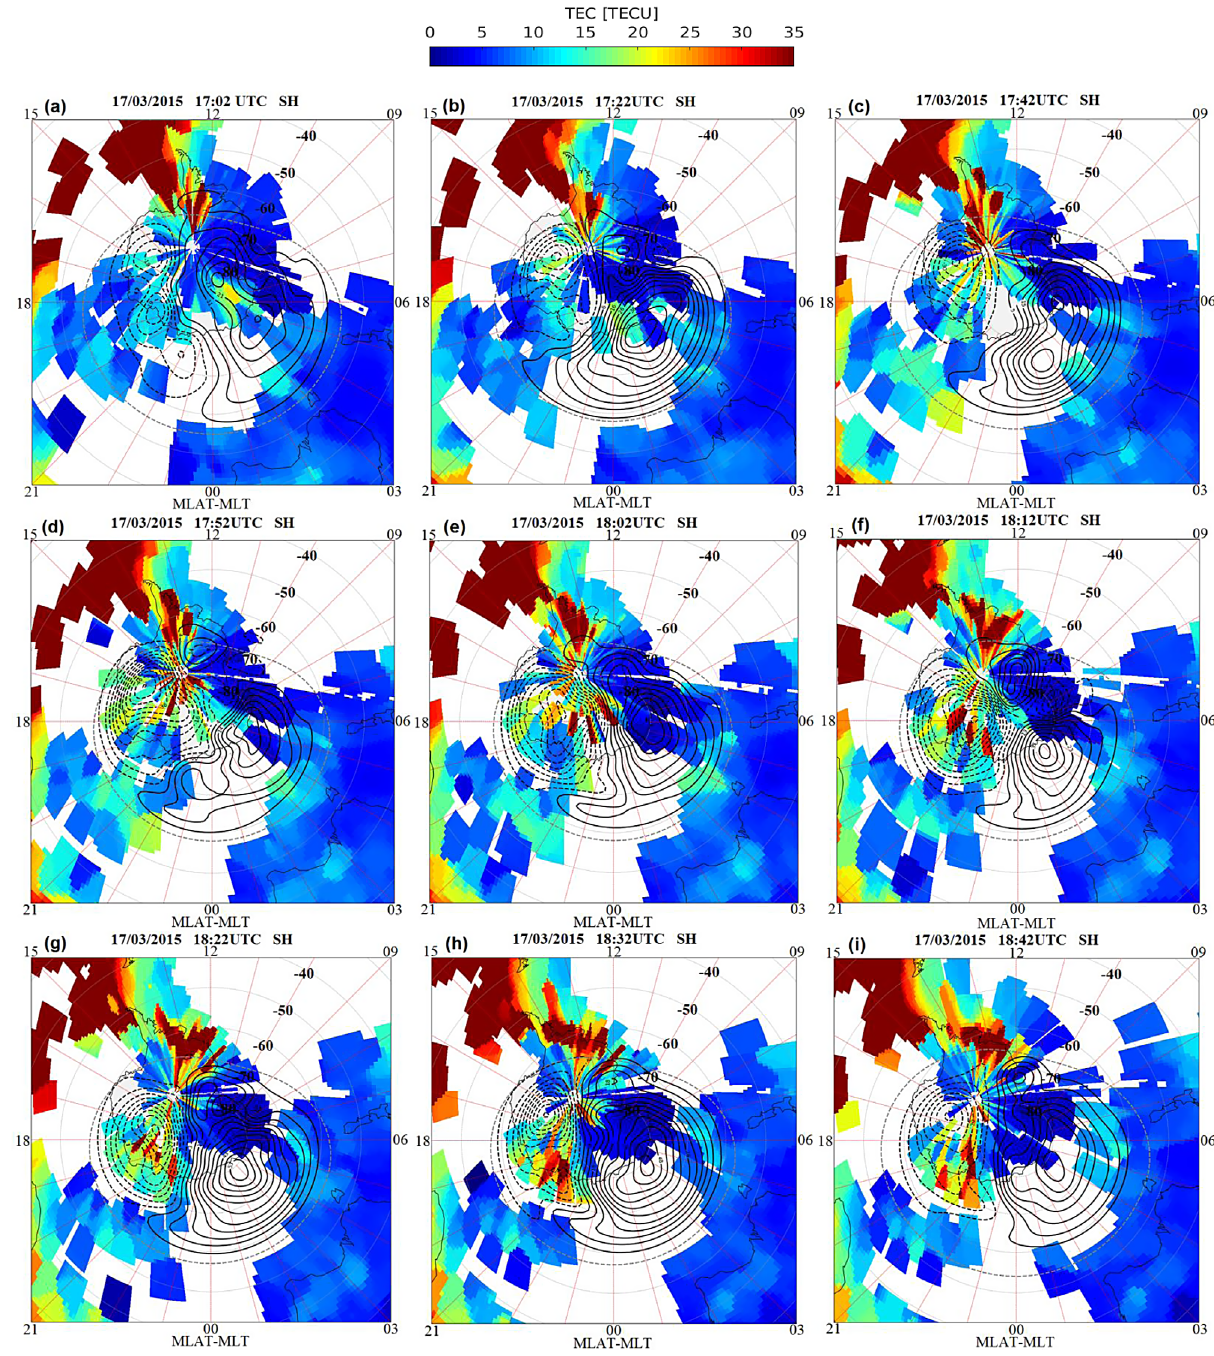
Fig. 2. Series of TEC maps as well as the ionospheric convection patterns in the geomagnetic latitude and magnetic local time coordinates. The convection patterns are provided by the SuperDARN